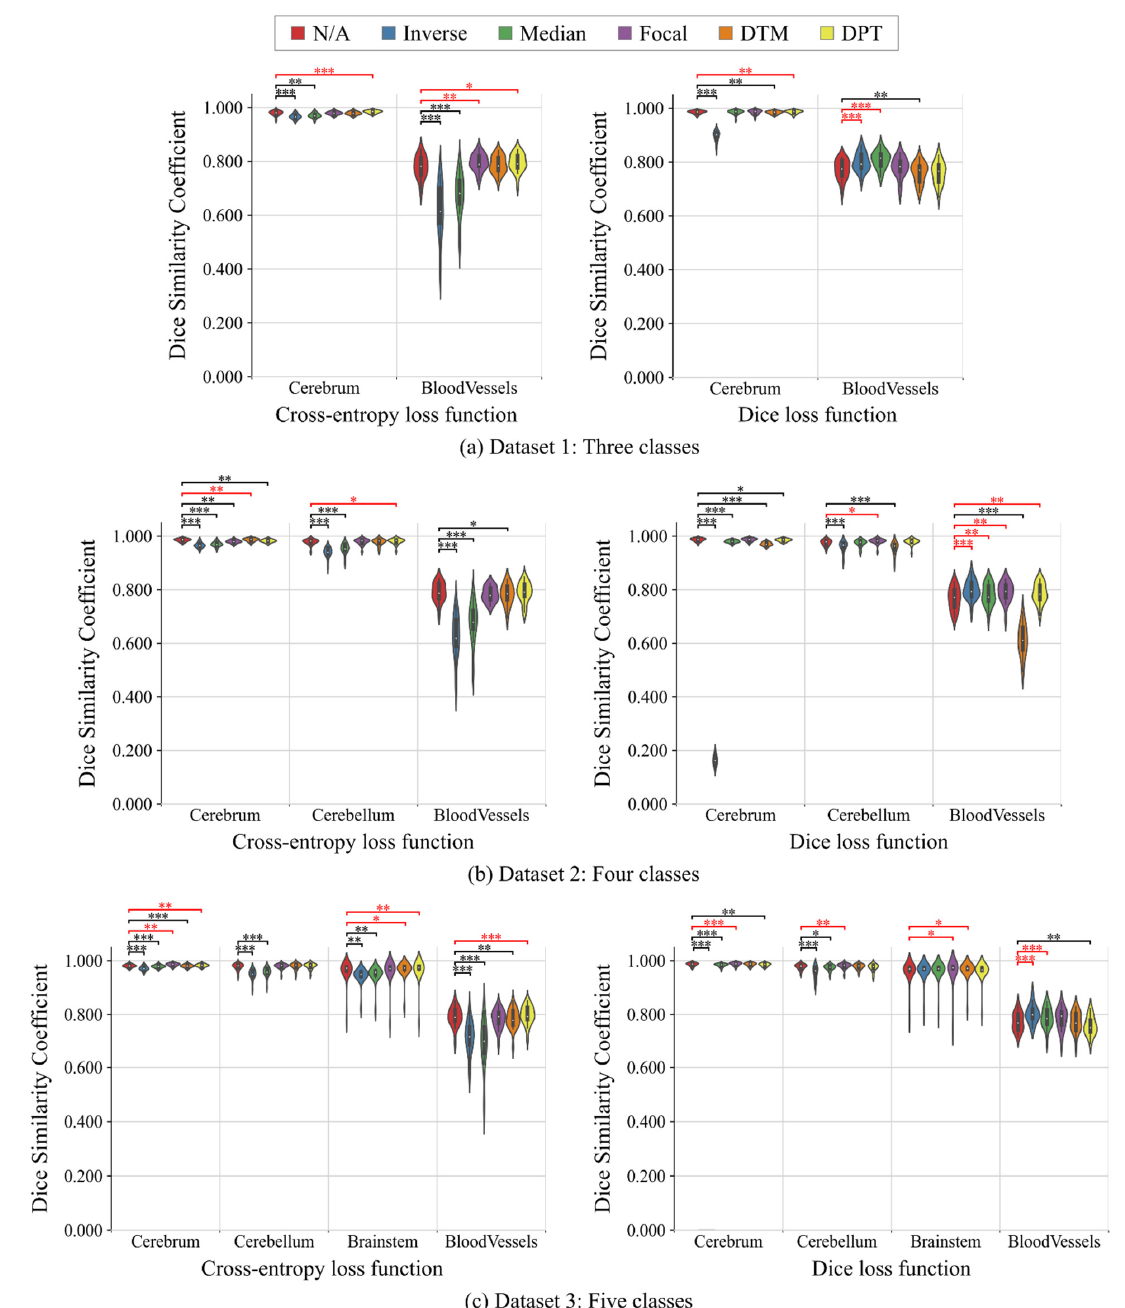
Figure 6. Violin plots of the segmentation results (Dice similarity coefficients) of no weighting (N/A), inverse frequency weighting (Inverse), inverse median frequency weighting (Median), focal weighting (Focal), distance transform map-based weighting (DTM), and distance penalty term-based weighting (DPT) in multi-class segmentation tasks. ( a ) Dataset 1: three classes, ( b ) Dataset 2: four classes, and ( c ) Dataset 3: five classes. Compared with the results of N/A, the significantly worse and better results are shown in black and red, respectively (Wilcoxon signed-rank test, * 𝑝 < 0.05 , ** 𝑝 < 0.01 , and *** 𝑝 < 0.001 , not adjusted for multiplicity).